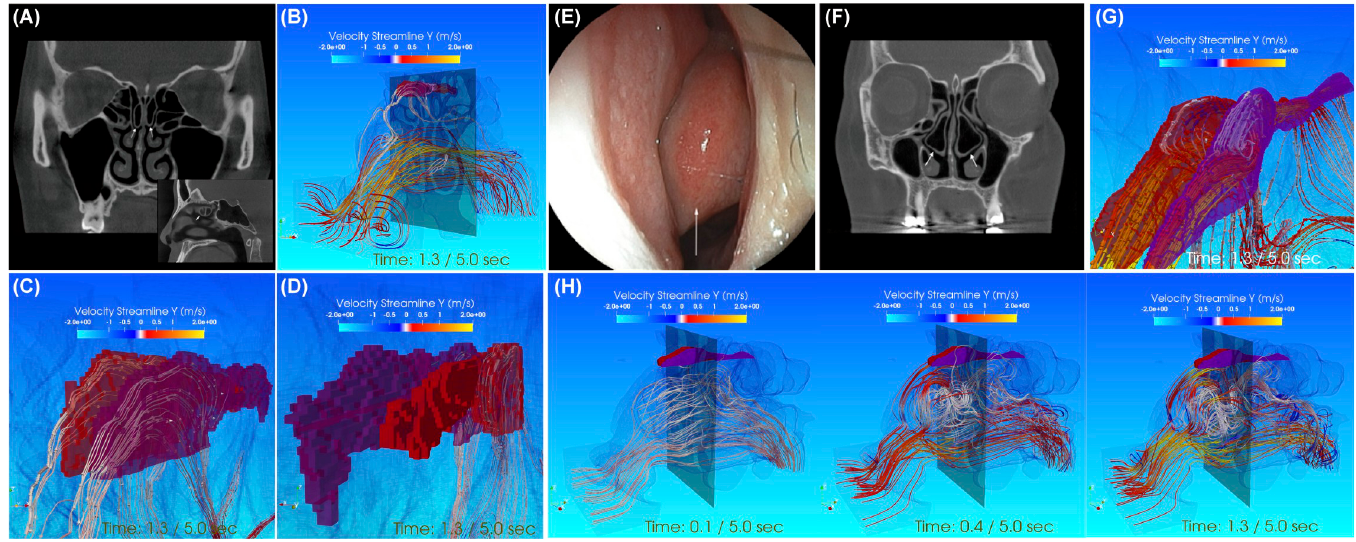
Fig 4. Two cases already known to cause COD. a.-g. Two cases already known to cause COD. a.-d. Characterization of the pneumatized superior turbinates in a participant in the conductive olfactory disorder without nasal polyps (CODsNP) group. a . Cone beam computed tomography (CBCT) scan in the coronal plane showing bilateral pneumatized superior turbinates (arrows). The sagittal plane showing a pneumatized superior turbinate on the left side (arrow). b . –d . The olfactory cleft is colored in red (right side) and purple (left side). b . Streamline diagram under maximum pressure during inspiration from a left anterolateral view. The velocity of airflow from the nasal vestibule toward the dorsal aspect of the olfactory cleft increases from red to yellow. c . , d . Streamline diagram under maximum pressure during inspiration around the olfactory cleft. The dorsal half of the bilateral olfactory clefts are tubular and blind ended. White indicates a relatively slow airflow velocity. The calculation grid is a cube with a slide length of 0.25 mm. c . Left anterolateral view. d . Right posterolateral view. e.-h. Characterization of concha bullosa in a participant in the conductive olfactory disorder without nasal polyps (CODsNP) group. e . Nasal endoscopy images of the left concha bullosa (arrow). f . Cone beam computed tomography (CBCT) scan in the coronal plane showing bilateral pneumatized middle turbinates (arrows). g . , h . The olfactory cleft is colored in red (right side) and purple (left side). g . Streamline diagram under maximum pressure during inspiration around the olfactory cleft. The bilateral olfactory clefts have a normal shape. The velocity of the bilateral olfactory cleft at the time of 1.3 s is over 2000 mm/s, and it does not actually occur because of combined mouth oral breathing. h . Streamline animation changing with inspiration time viewed from the left front (upper picture series). The olfactory cleft is colored: right (red cubes), left (purple cubes). In our simulation, a relatively slow speed vortex occurred in front of the bilateral middle turbinates, 0.1–0.4 s after the start of inspiration. It becomes the maximum pressure gradient at the time of intake after 1.3 s have passed. E.g., The mucous membrane was red in the part of the middle turbinate where the slow velocity vortex was